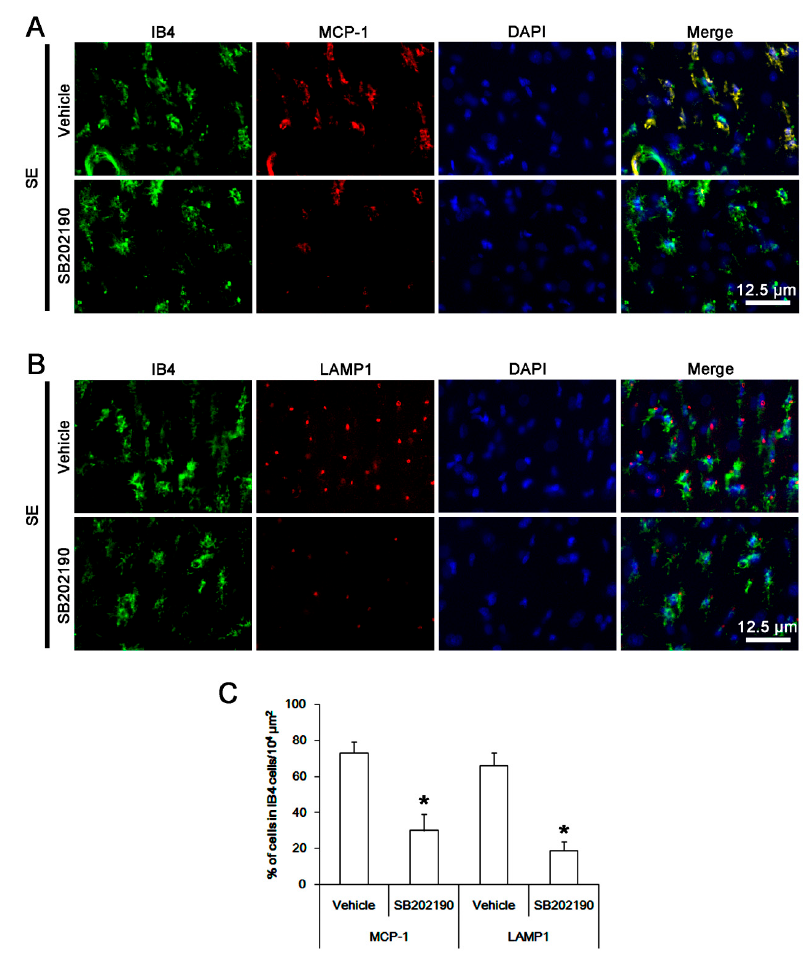
Figure 7. The effects of SB202190 on MCP-1 induction and phagocytosis of resident microglia after SE. As compared to vehicle, SB202190 diminishes MCP-1 and LAMP1 expressions in IB4 microglia following SE. ( A , B ) Representative images for MCP-1 and LAMP1 expressions in IB4 microglia. ( C ) Quantification of the effects of SB202190 on MCP-1 and LAMP1 expressions in IB4 microglia following SE. Error bars indicate SEM ( *p < 0.05 vs. vehicle-treated animals; n = 7, respectively).